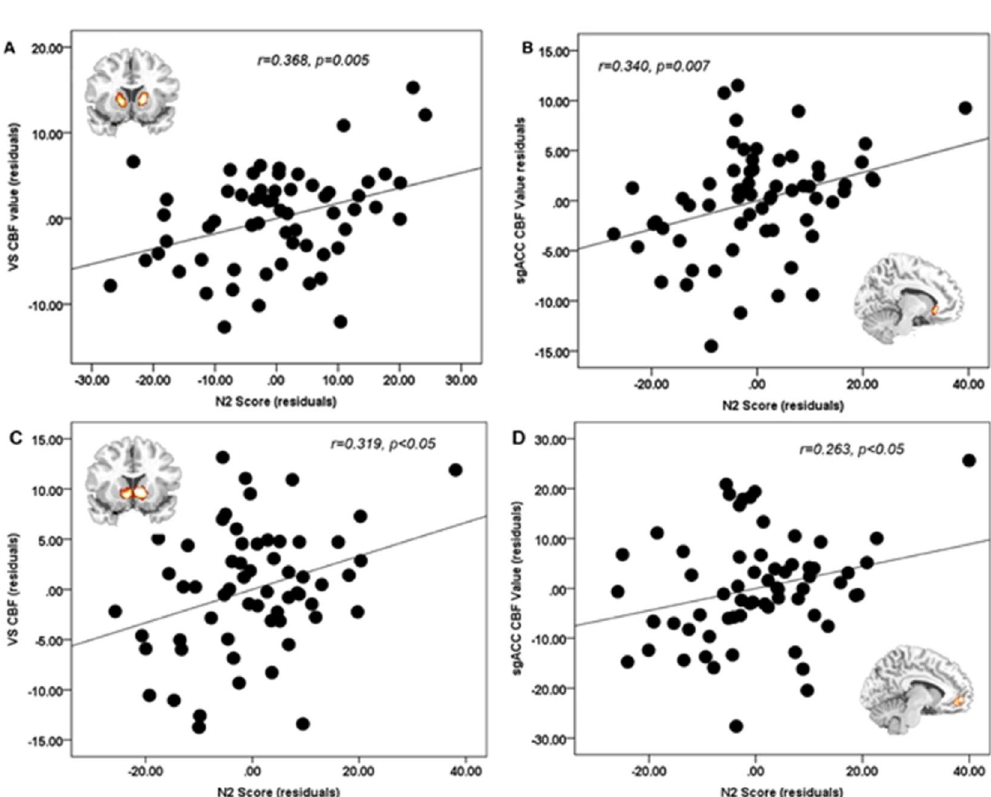
Figure 2. Association between resting CBF values and DIT-N2 Scores. Resting CBF values in ( A ) ventral striatum and ( B ) ventromedial prefrontal region were positively correlated with DIT-2 N2 scores. The functional ventral striatum (VS) ROI and the ventromedial prefrontal ROI were defined based on the CBF results. Independent ROI analyses revealed similar results that ( C ) VS and ( D ) ventromedial prefrontal regions were positively correlated with DIT-2 N2 scores. The independent VS ROI and ventromedial prefrontal ROI were defined based on previous literature 24 . Openness and Neuroticism were controlled in the partial correlation